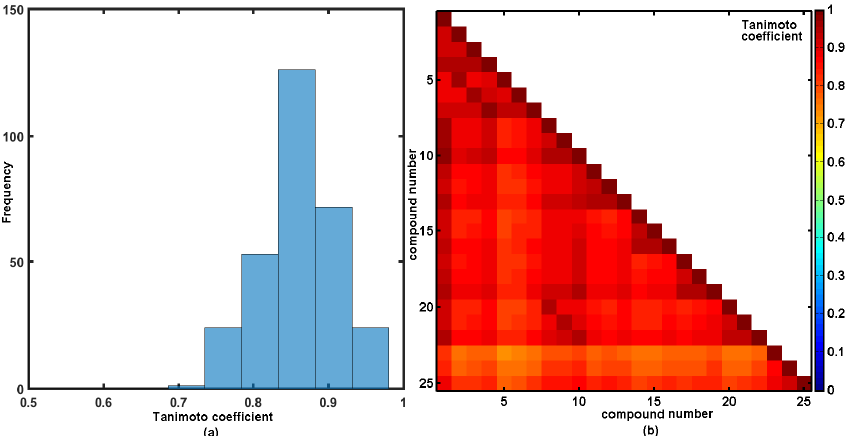
Figure 4. Distribution of Tanimoto coe ffi cients ( a ) and the triangular matrix of Tanimoto coe ffi cients ( b ) Figure 4 . Distribution of Tanimoto coefficients ( a ) and the triangular matrix of Tanimoto coefficients for silicon-based carbamates 1 – 25 ( b ) for silicon-based carbamates 1 – 25 .